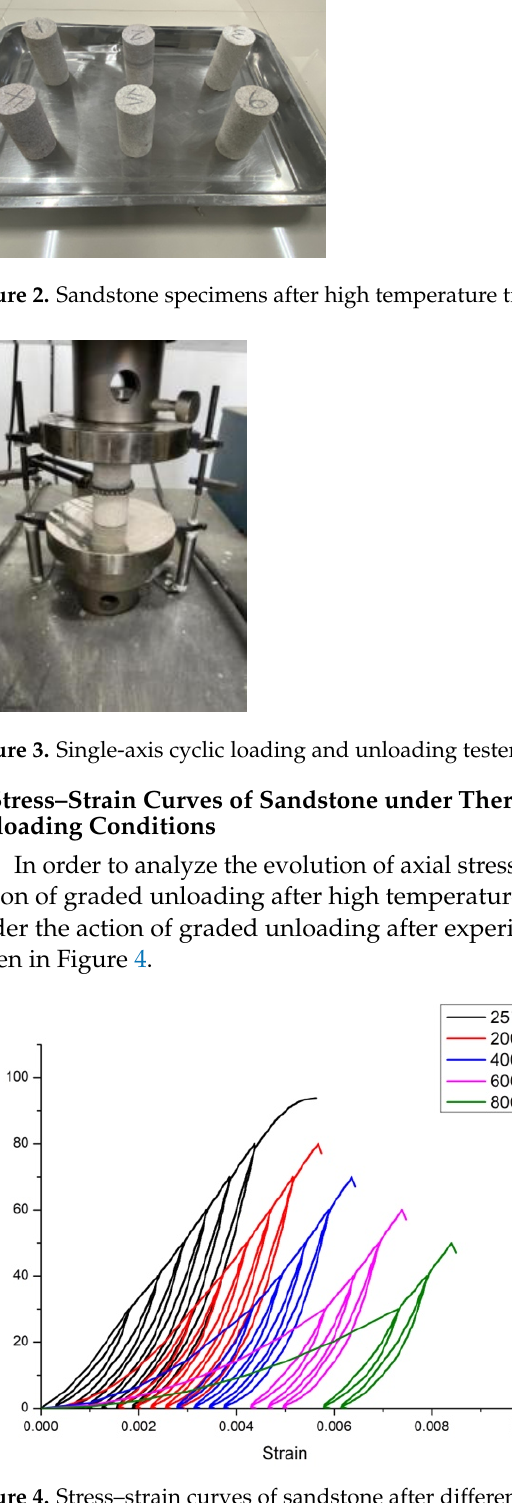
Figure 4. Stress–strain curves of sandstone after different high temperatures.